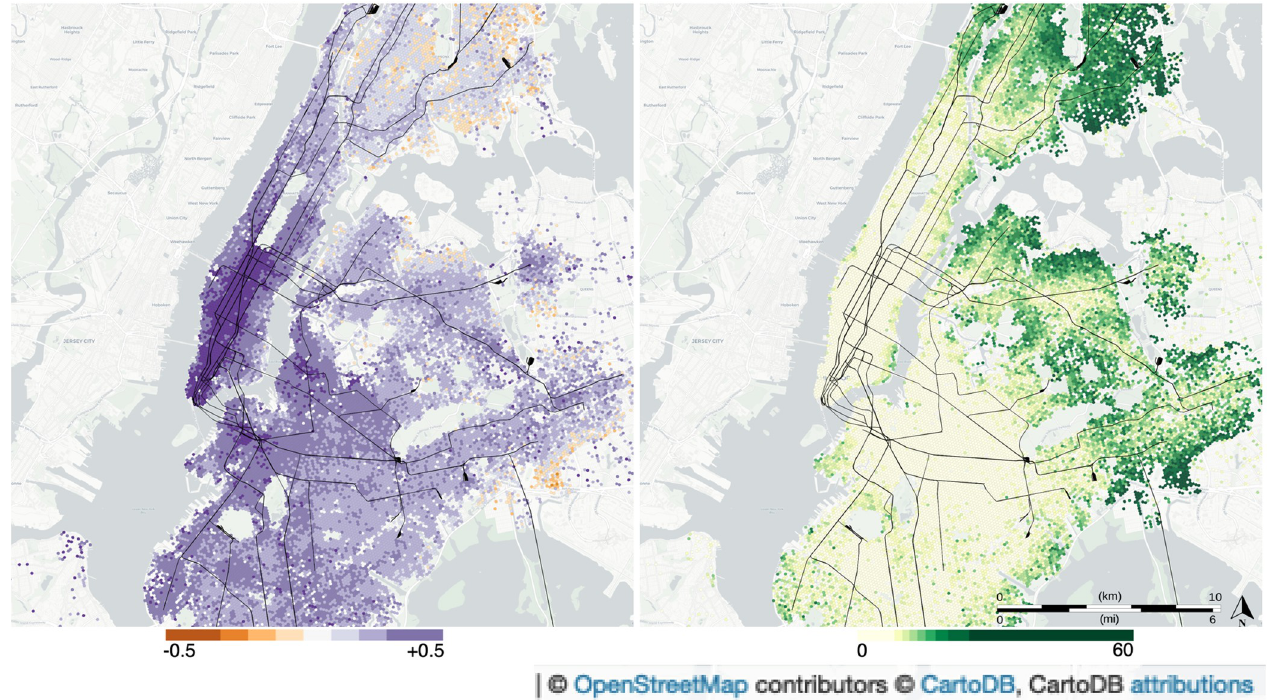
Fig 4. Zonal Modal Accessibility Gap between public transport and ride-hailing in New York City for generalized travel cost (left) and increase in service accessibility associated with Uber (right) with a high spatial resolution.